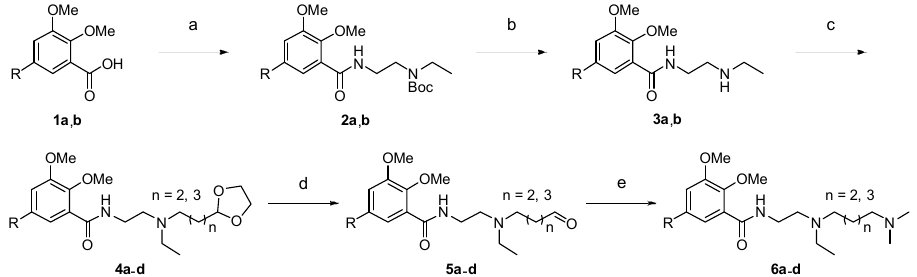
Scheme 1. Synthesis of 3-fluoropropyl or bromo analogs 6a – d . Reagents and conditions: (a) tert - butyl (2-aminoethyl) ethylcarbamate, HBTU, DIPEA, DMF, RT, 24 h; (b) TFA, CH 2 Cl 2 , 0 ◦ C to RT, 1 h;